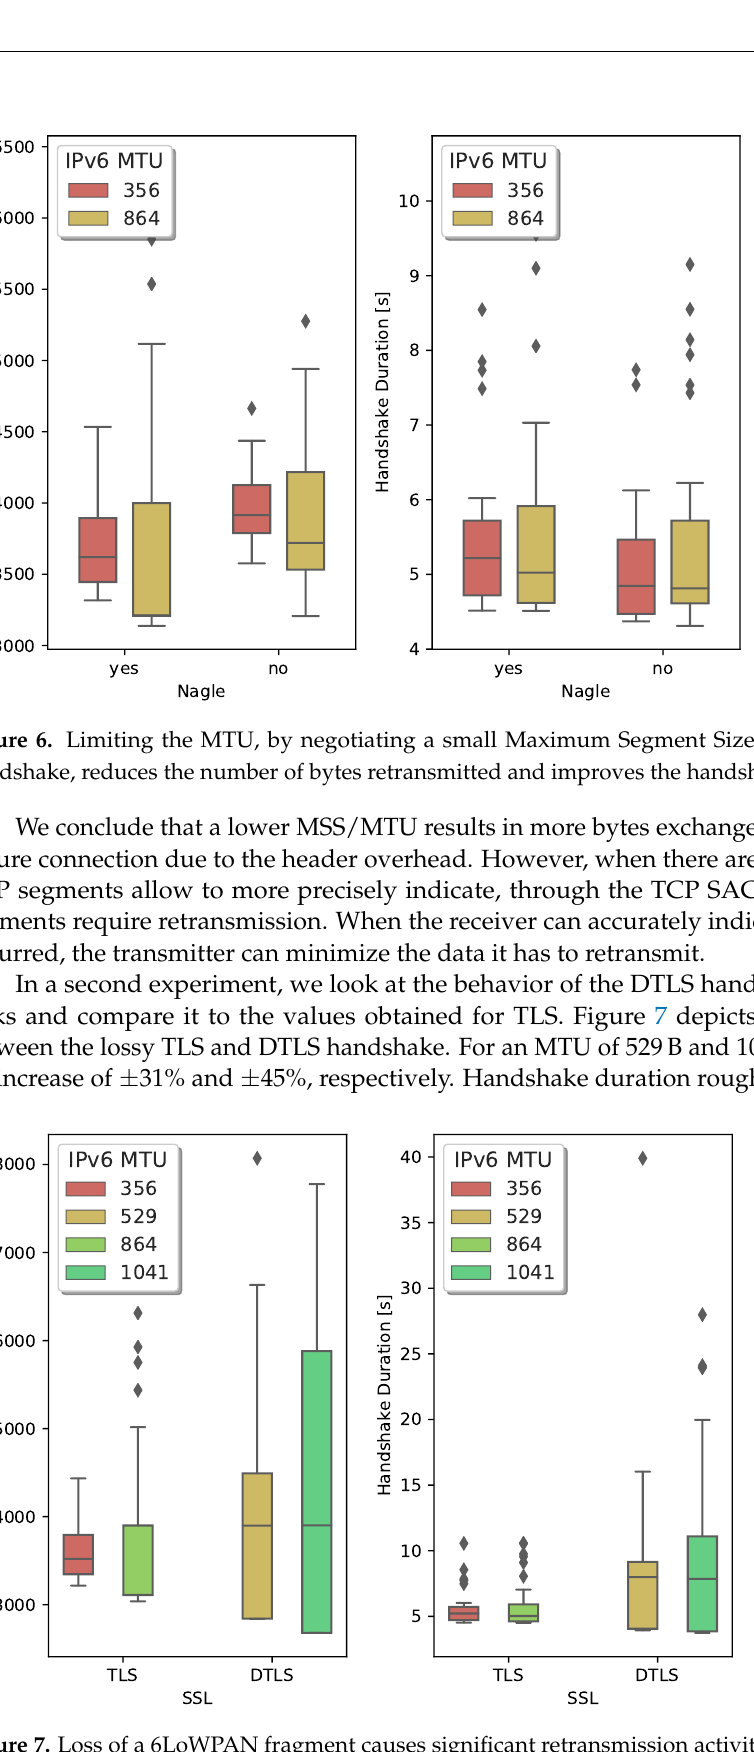
Figure 7. Loss of a 6LoWPAN fragment causes significant retransmission activity during the DTLS handshake. A properly configured TCP stack recovers the lost fragment with minimal impact on the 6TiSCH